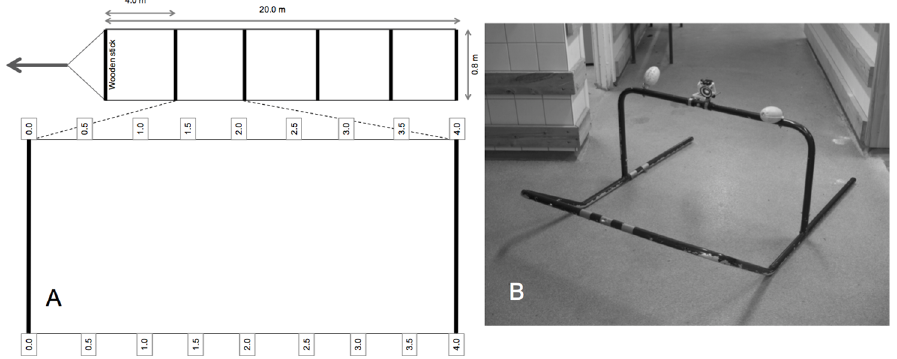
Fig 2. Schematic drawing of the sample transectsand the video sled. (A) Schematic drawingof the dimensions of the sample transect and the location markers and (B) photo of the simple sled design and the positionof the video